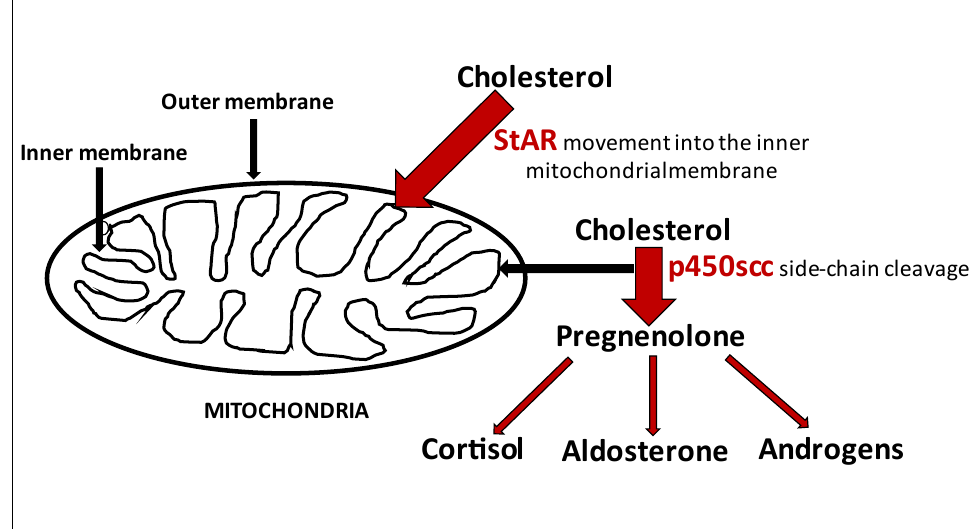
Figure 1. Two initial steps of steroidogenesis related to the StAR and p450scc activity.